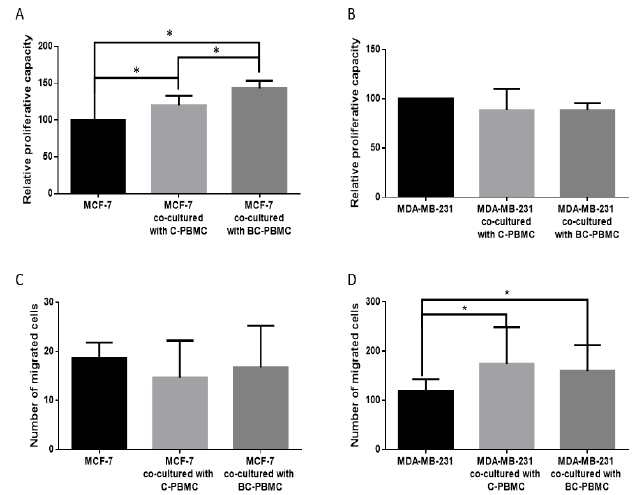
Figure 5. Relative proliferative capacity of breast cancer cell lines MCF-7 ( A ) and MDA-MB-231 ( B ) after cultured in presence of cm-PBMC, both from C-PBMC ( n = 9) and BC-PBMC ( n = 6). Invasive capacity of breast cancer cell lines MCF-7 ( C ) and MDA-MB-231 ( D ) after co-culture with C-PBMC and BC-PBMC in Matrigel invasion chambers. Data represent the mean ± SD. (* p ≤ 0.05).